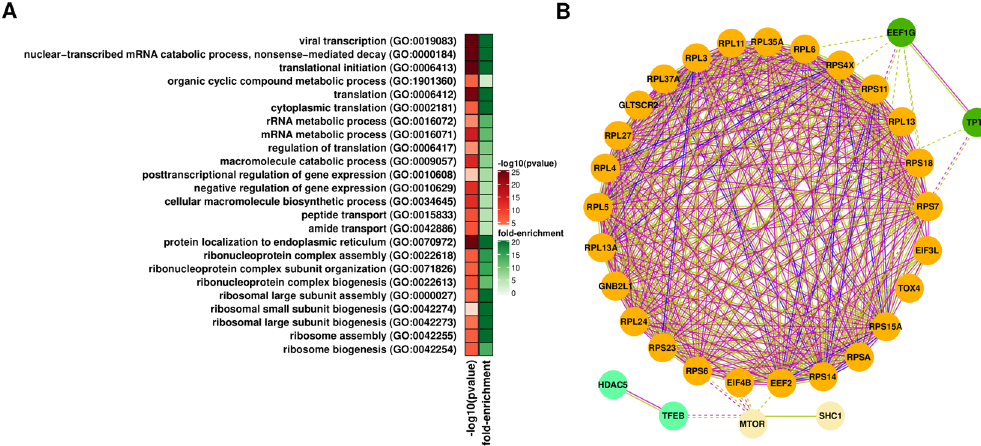
Figure 5. Impact of radiation on the translation profile of glioblastoma cells. ( A ) GO-enriched terms among genes showing changes in translation efficiency at T24. GO-enriched terms are summarized using REVIGO 97 . ( B ) Protein-protein interaction network, according to STRING 98 showing genes whose translation efficiency decreased at T24. Gene clusters based on the strength of connection and gene function are identified by color. Line colors indicate the type of association: light green, an association based on literature findings; blue indicates gene co-occurrence; magenta indicates experimental